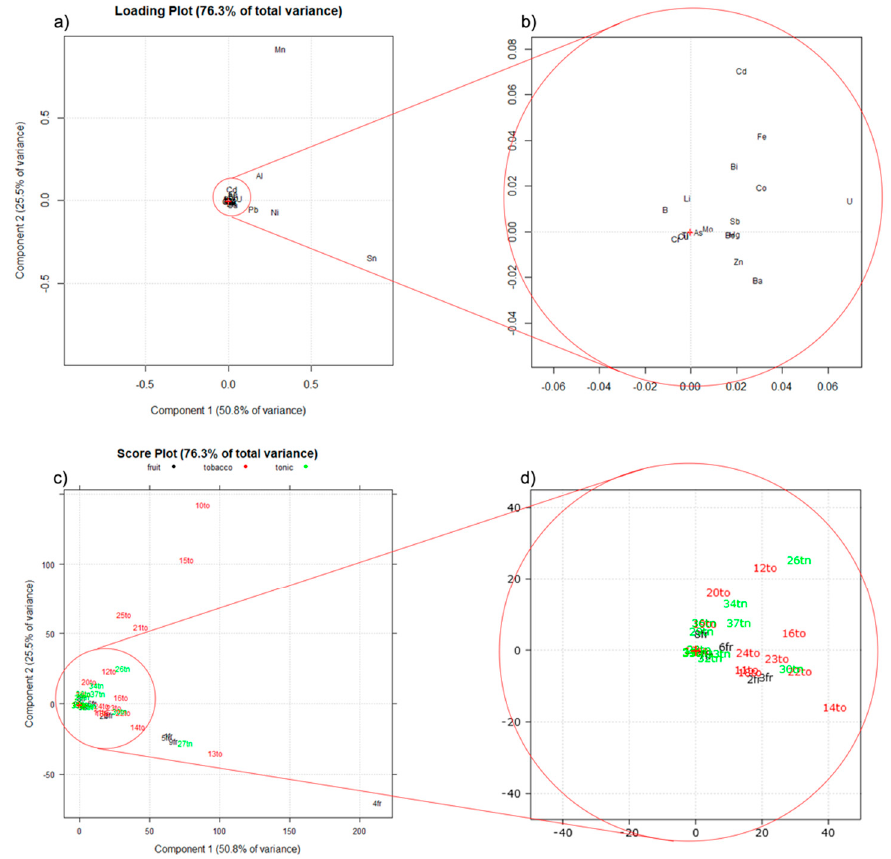
Figure 5. PCA performed on the same dataset processed and normalized, for each analyte, with respect to the relevant concentration measured in the synthetic matrix (SM). ( a ) Loading plot; ( b ) zoomed view of the loading plot; ( c ) score plot; ( d ) zoomed view of the score plot; to: tobacco flavored samples; fr: fruity-flavored samples; tn: tonic-flavored samples.